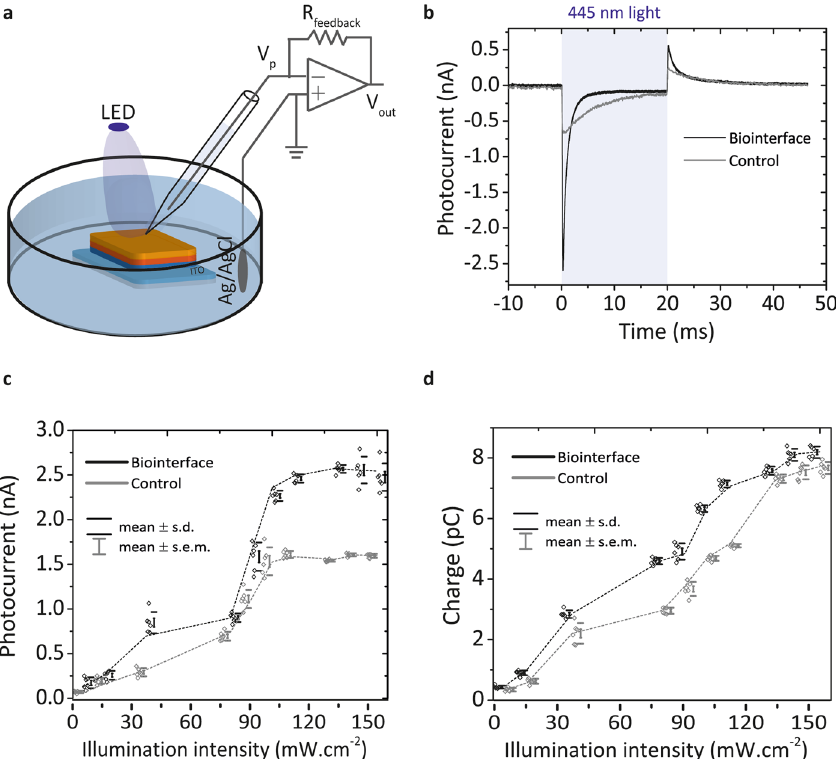
Fig. 3 Optoelectronic responses with AlSb NCs by using patch-clamp measurement system. a Schematic of the patch-clamp photocurrent measurement system. The glass pipette was positioned close to the surface of the biointerface and control device (<5 µ m). ITO layer was in direct contact with electrolyte to be used as the return electrode. b Photocurrent response upon illumination with trains of 20 ms, 100 mW cm − 2 , 2 Hz light pulses for control (gray) and biointerface (black). Blue semi-transparent area shows the 445nm light illumination period. c Photocurrent and d charge injection amounts under different illumination intensities (means ± s.e.m., means ± s.d., n =